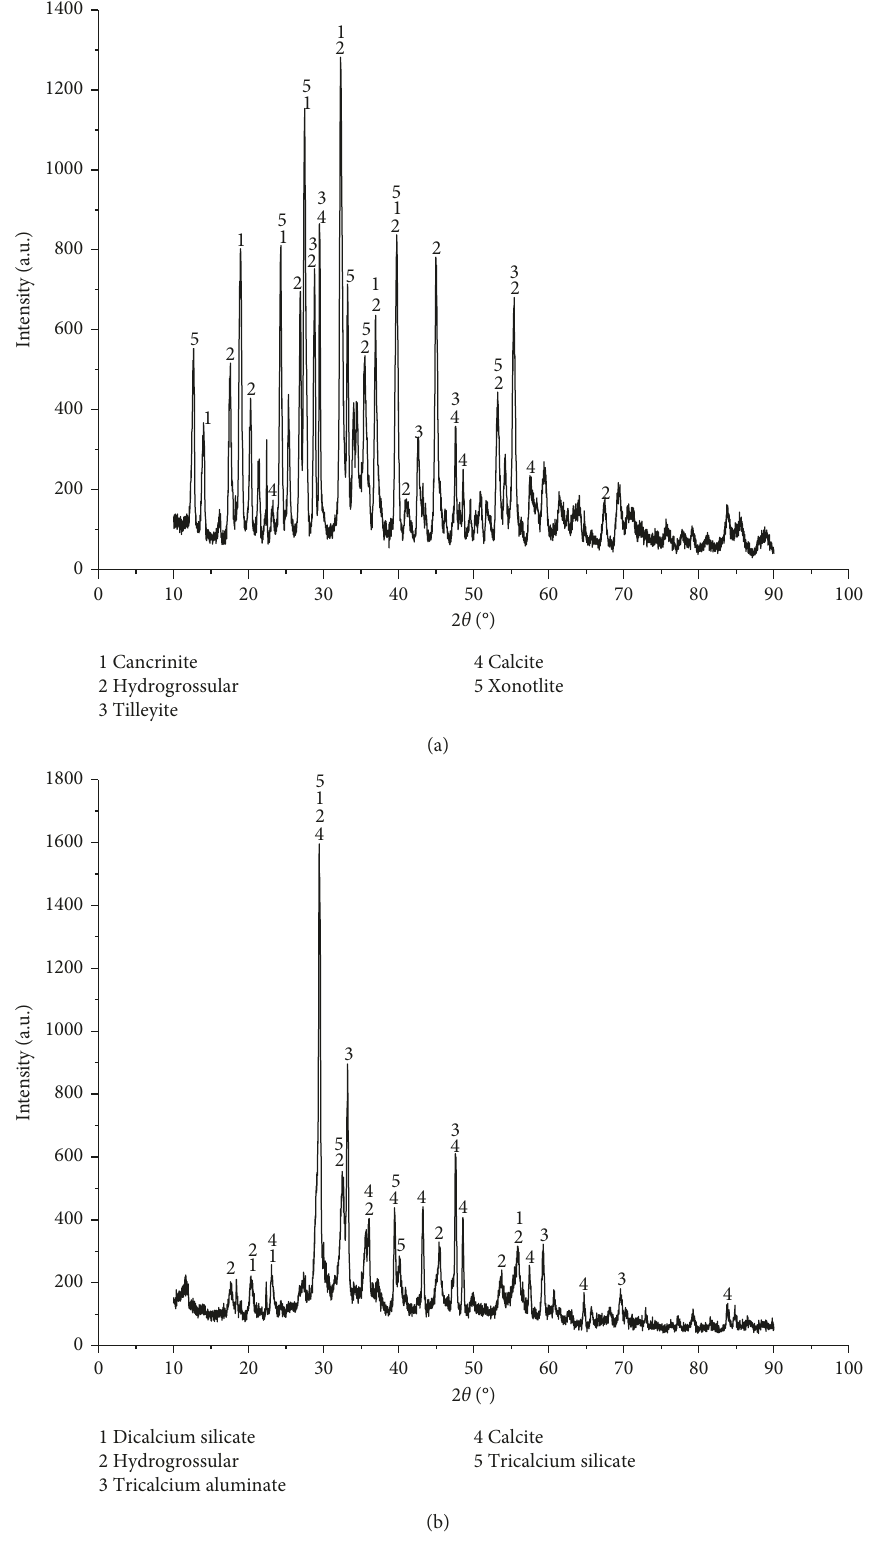
Figure 4: XRD pattern of different red mud: (a) Bayer red mud and (b) sintering red